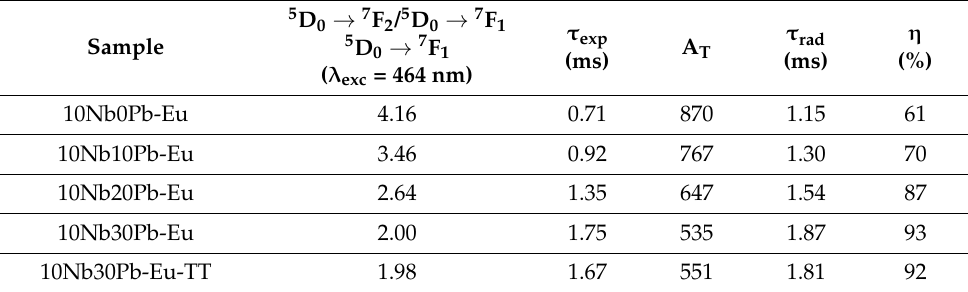
Table 2. 5 D 0 → 7 F 2 / 5 D 0 → 7 F 1 intensity ratios, experimental lifetime ( τ exp , ms) from 5 D 0 → 7 F 2 transition for Eu 3+ ions, total radiative transition probability from level 5 D 0 (A T , s − 1 ), radiative lifetime ( τ rad , ms), and quantum efficiency ( η , %) in Eu 3+ -doped glasses and glass-ceramic.